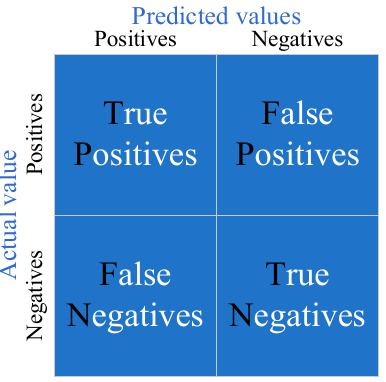
Figure 8. Principles of sample classification.